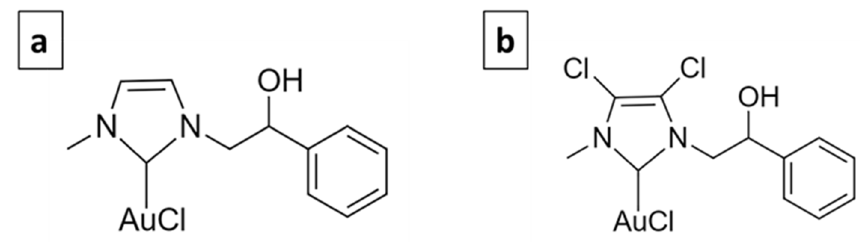
Figure 1. AuL20 ( a ) and AuM1 ( b